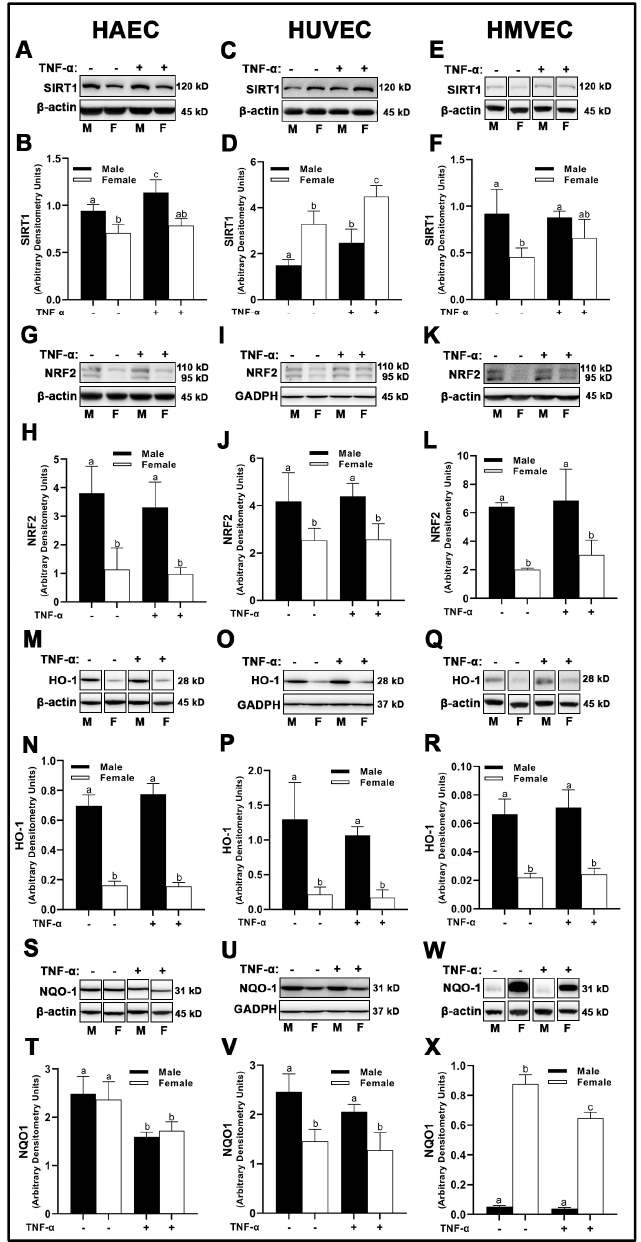
Figure 7. Expression of endogenous antioxidant regulators in male and female endothelial cells. HAECs, HUVECs and HMVECs were cultured in starvation medium at ~80% confluency for 24 h with or without TNF- α (20 ng/mL). Protein expression of SIRT1 ( A – F ), NRF2 ( G – L ) and HO-1 ( M – R ) and NQO1 ( S – X ) were determined by Western blot. Quantification was performed using Image Lab (Bio-Rad Laboratories, Inc.). Protein was normalized to respective control bands ( β -actin or GAPDH). Data are expressed as mean ± SD from 4–6 experiments. Data were statistically analyzed with one-way ANOVA followed by Tukey post hoc multiple comparison analysis between groups. Values that do not share the same letter are significantly different from each other ( p ≤ 0.05).